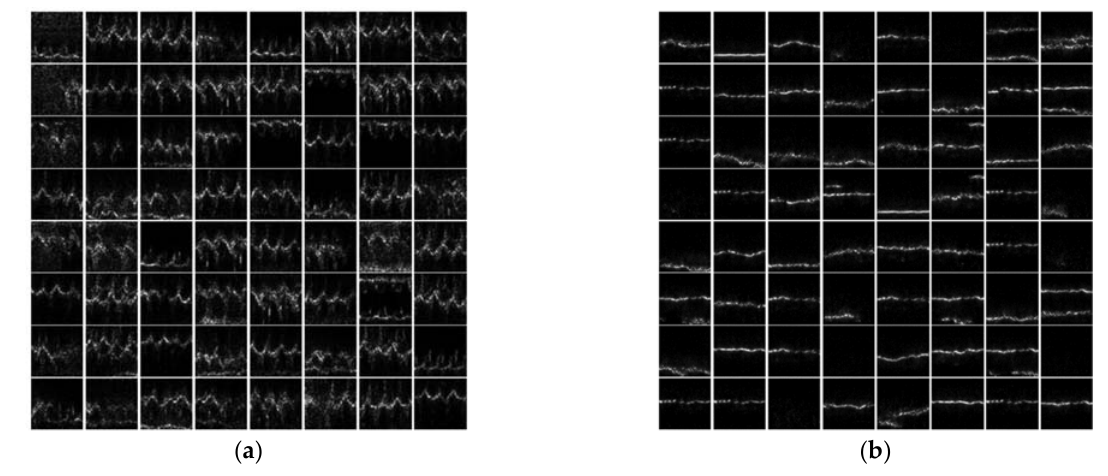
Figure 10. Generated samples of the semi ‐ measured pedestrian postures database obtained from the MOCAP and EM data. ( a ) Walking; ( b ) jumping; ( c ) running.